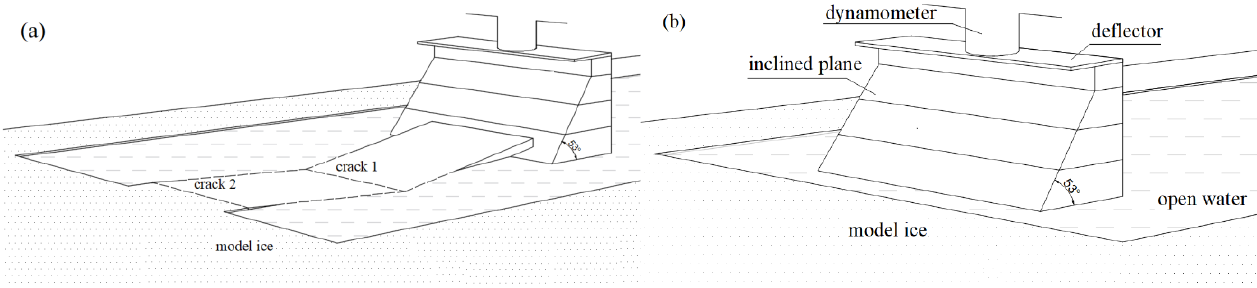
Figure 1. A scheme of the experiments with an inclined model: ( a ) against a large ice cantilever beam and ( b ) imitating contact with a semi-infinite plane.